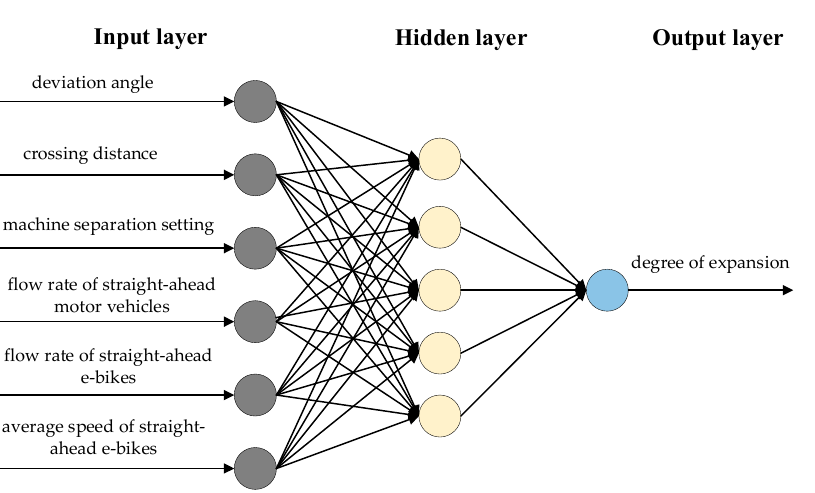
Figure 7. The neural network